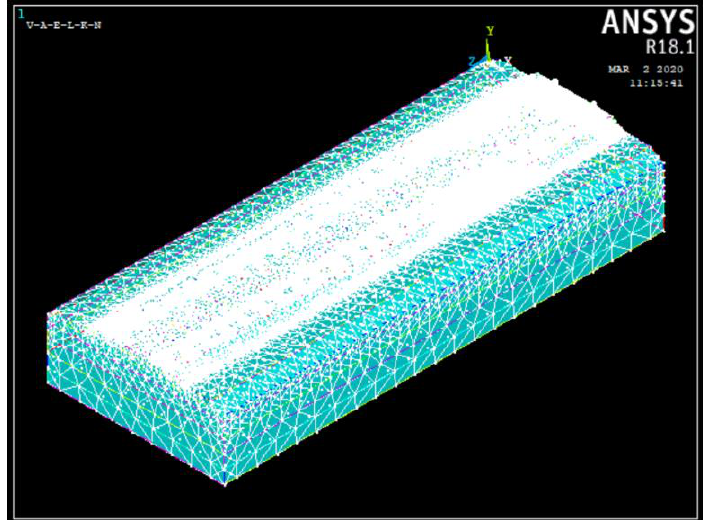
Fig. 6. Rail Track Model after mesh generation in